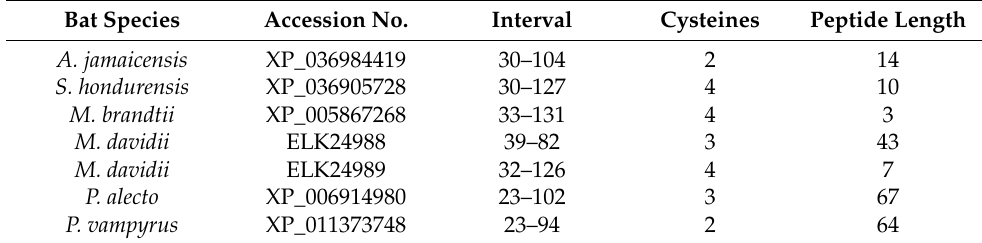
Table 2. Bat cathelicidin sequences rejected from further structural analysis, due to lack of conserved cysteines within the cathelin-like region or to the missing of the portion of the cathelicidin active peptide. The interval shows the region of homology with the superfamily member pfam00666.